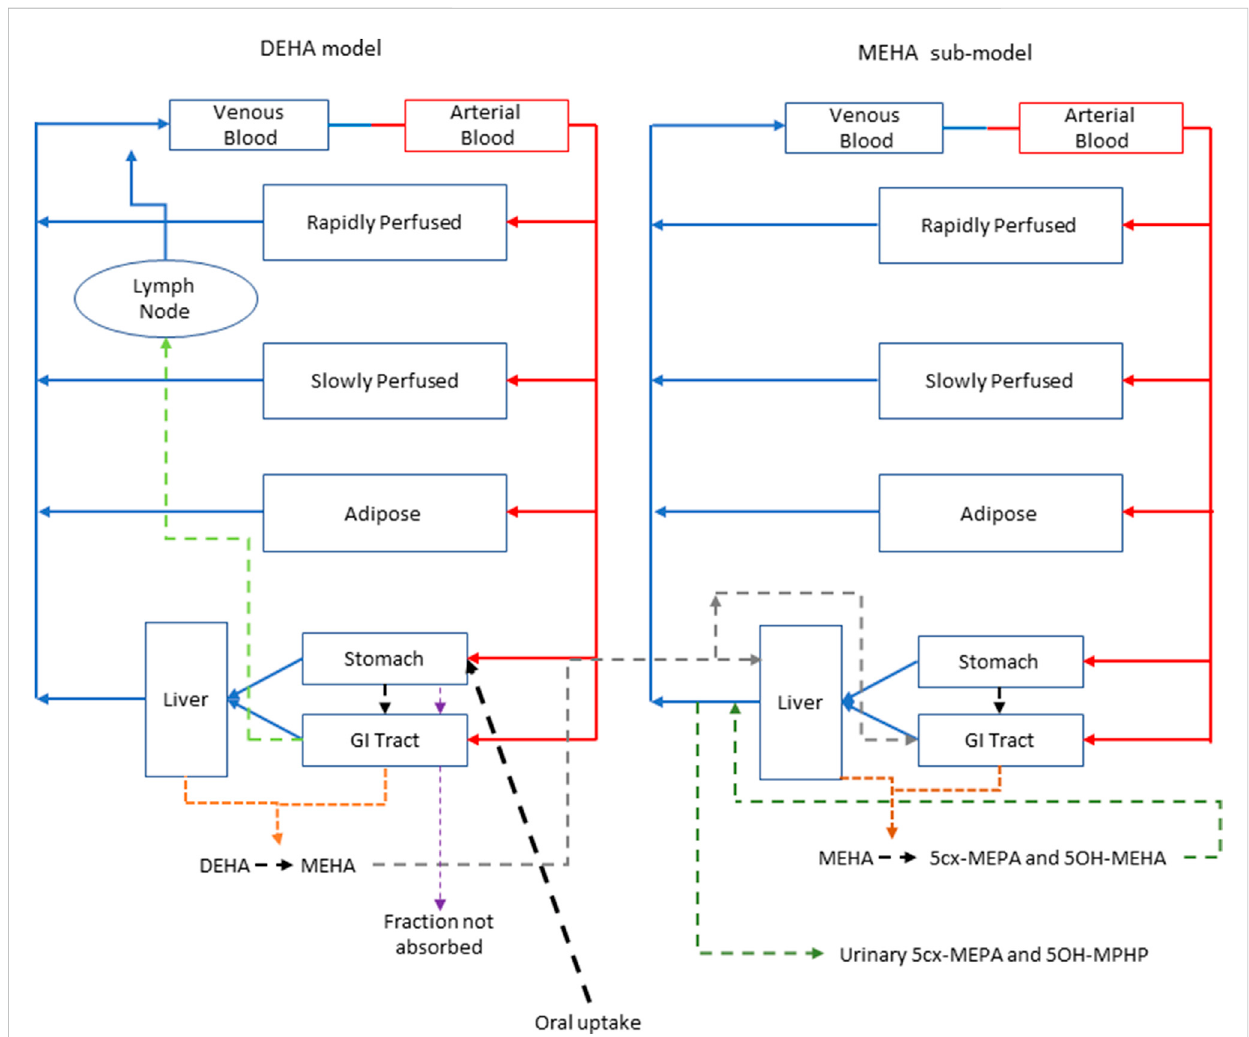
A schema of the model for DEHTP and sub-model for MEHTP. The main model contained a lymphatic compartment (- - - -) which received a portionoforaldosefromthestomachandGItract.Urinaryexcretionofmetaboliteswasdescribedwitha fi rst-ordereliminationrateconstantascribedto the